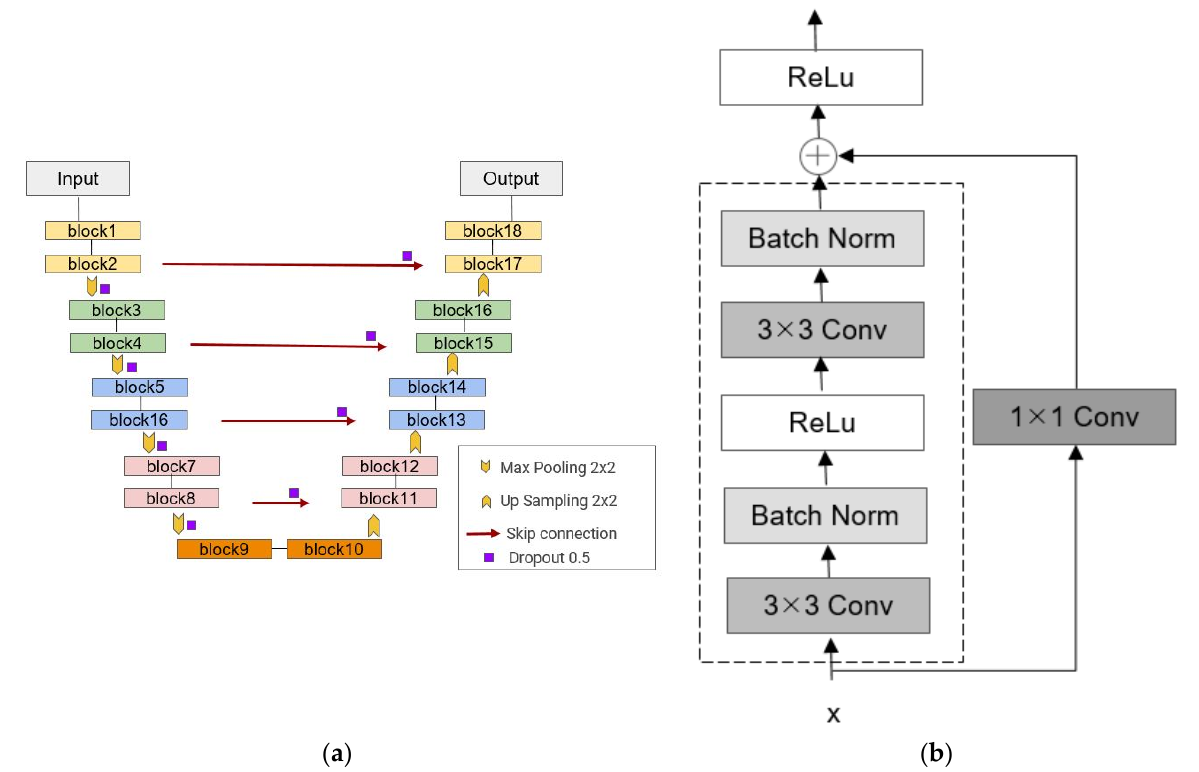
Figure 9. ResU ‐ Net2 network structure: ( a ) ResU ‐ Net2 network framework and ( b ) block modules. Figure 9. ResU-Net2 network structure: ( a ) ResU-Net2 network framework and ( b ) block